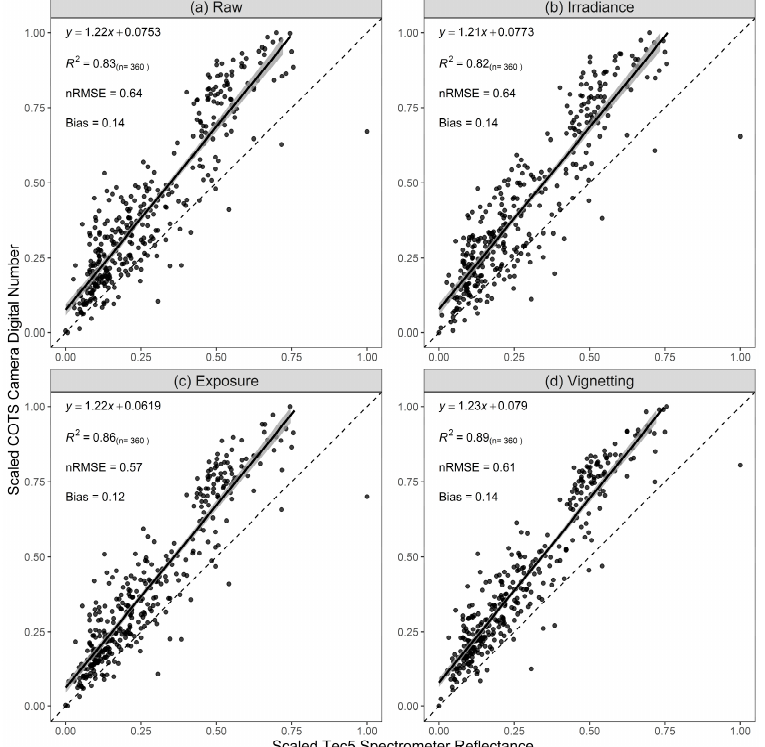
Figure 7. Assessment of the cumulative influence of correction steps on the precision of scaled mean plot measurements in the Red band. Scaled reflectance for ( a ) Raw, ( b ) Irradiance, ( c ) Exposure and ( d ) Vignetting corrected images are compared to scaled COTS camera convolved Tec5 measurements of mean plot reflectance. The dashed line represents the 1:1 line.